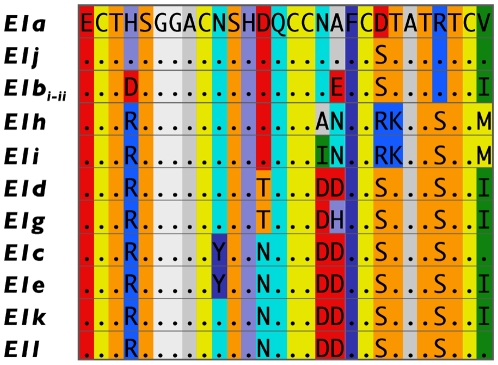
Predicted amino acid sequences of the toxin coding region of alleles of conotoxin locus E1 of Conus ebraeus.Amino acids are provided as single letter codes; dots are used to indicate identity to the amino acid of the first sequence given. To illustrate radical amino acid substitutions, amino acids with similar chemical properties are provided in similar background colors (coloring based on the ‘amino’ scheme utilized in Jmol, a Java viewer for chemical structures (http://www.jmol.org/)). Amino acid sequences of E1bi and E1bii were combined because they exhibit no nonsynonymous substitutions with the toxin coding region.